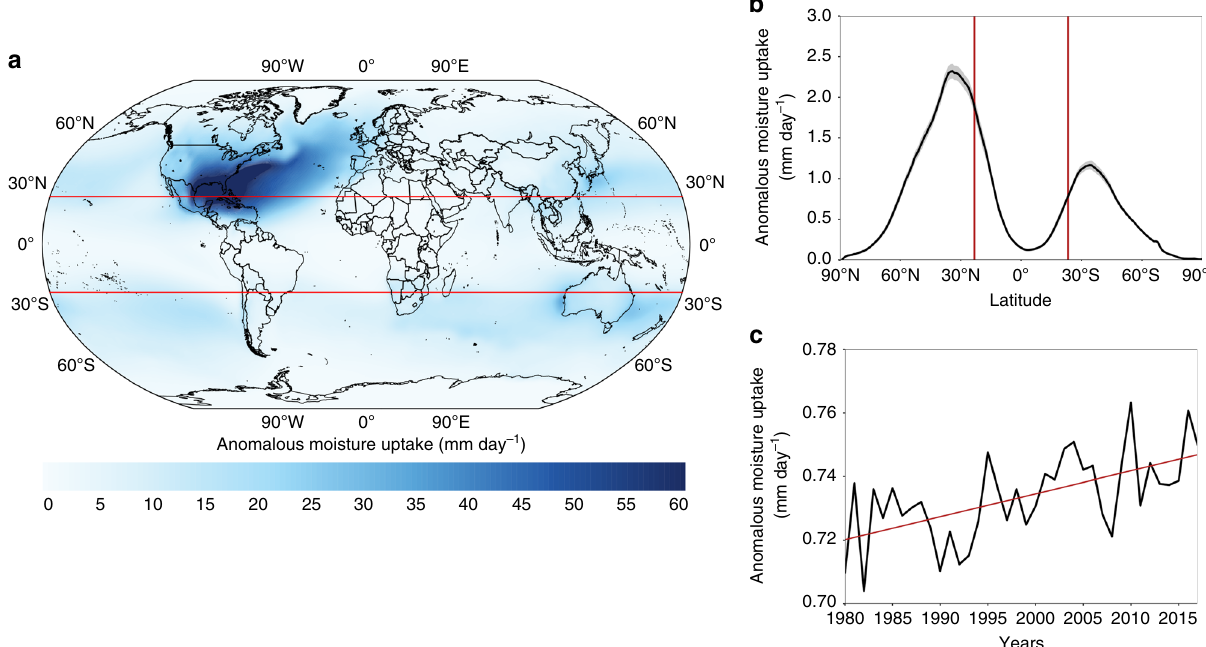
Fig. 3 Anomalous moisture uptake of the landfalling Atmospheric Rivers events from 1980 – 2017. a Annual sum of positive anomalies of moisture uptake for Atmospheric Rivers (ARs) detections over the main landfalling regions. The red lines de fi ne the region between the Tropics of Cancer (23.43°N) and Capricorn (23.43°S). The anomalies are calculated over the period 1980 – 2017. b Zonal average of Anomalous Moisture Uptake (AMU, black line) and its interannual variability (shaded gray area). c Global annual variability of AMU. The red line shows the corresponding linear